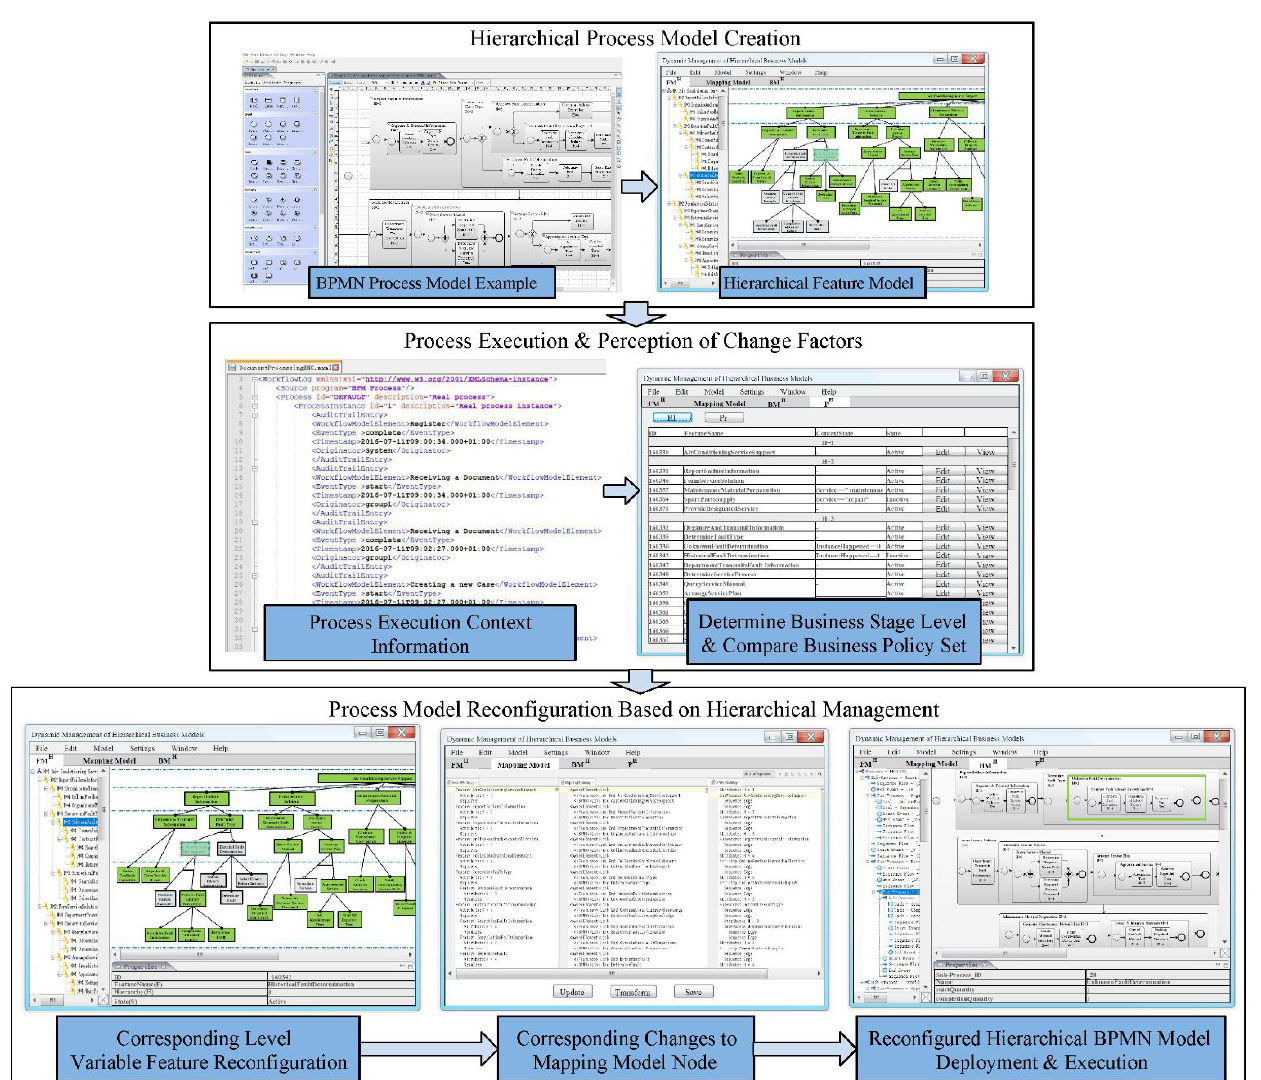
Figure 9. Application examples of business process dynamic adaptation tool.